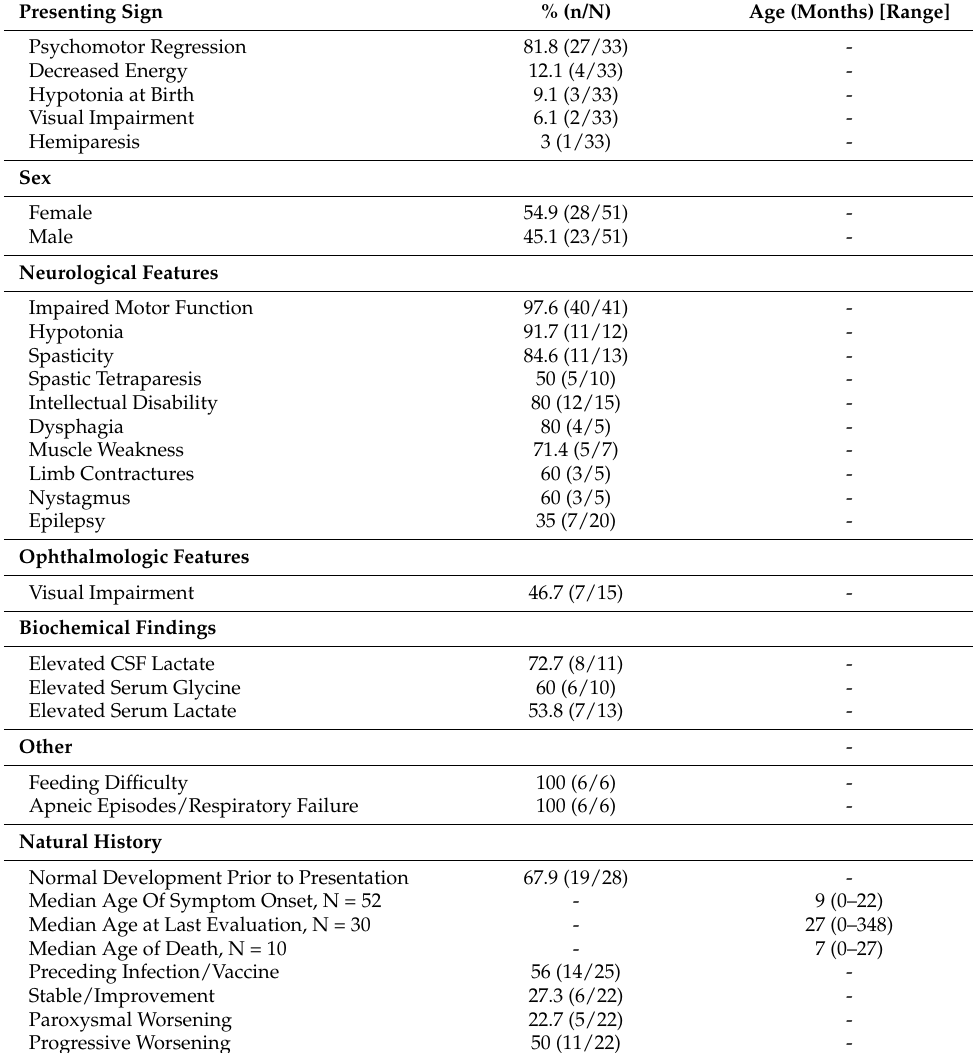
Table 2. Clinical characteristics of multiple mitochondrial dysfunction syndrome type 3